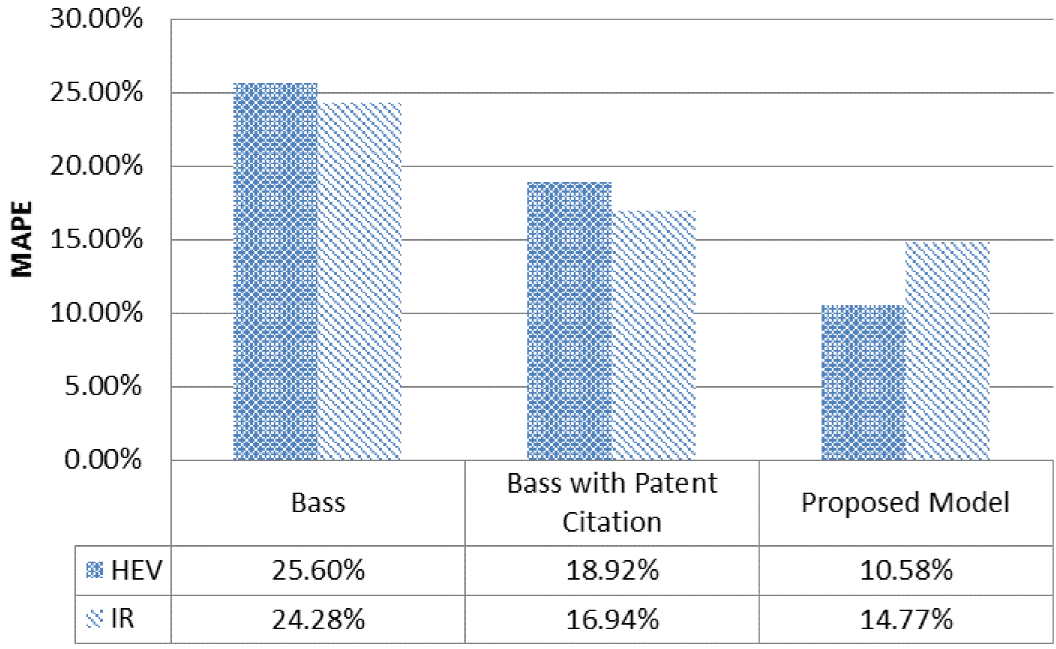
Fig 3. Accuracy comparison for hybrid cars and industrial